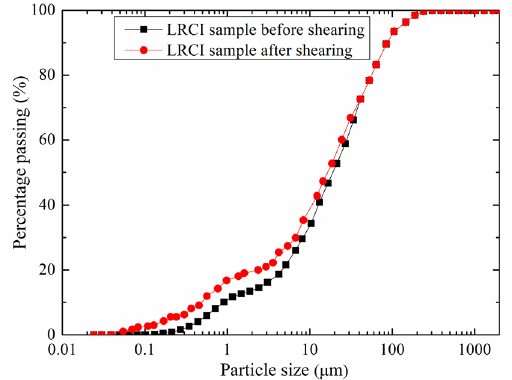
Figure 12. Particle size distribution of LRCI shear surface before and after shearing.